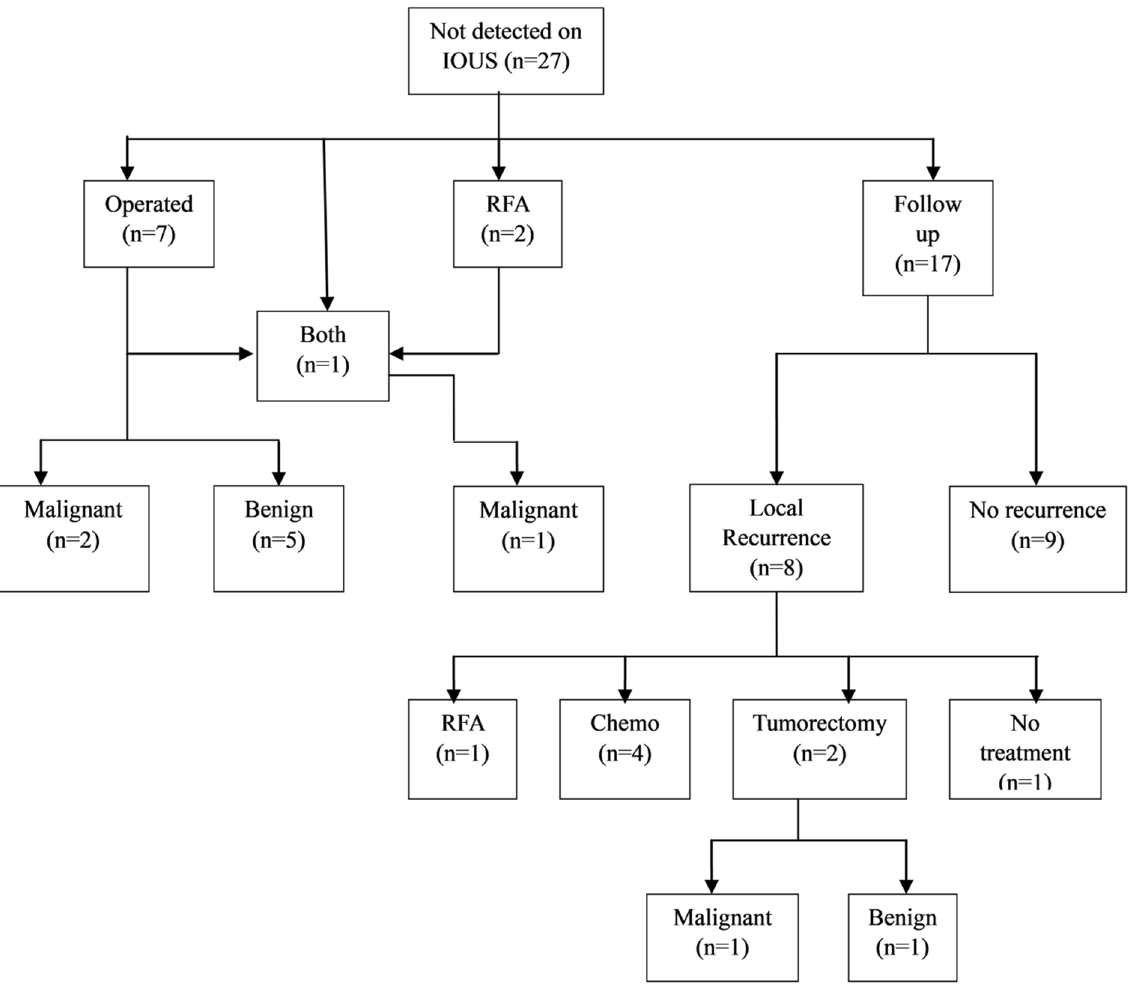
Figure 3. Indeterminate nodules not detected on